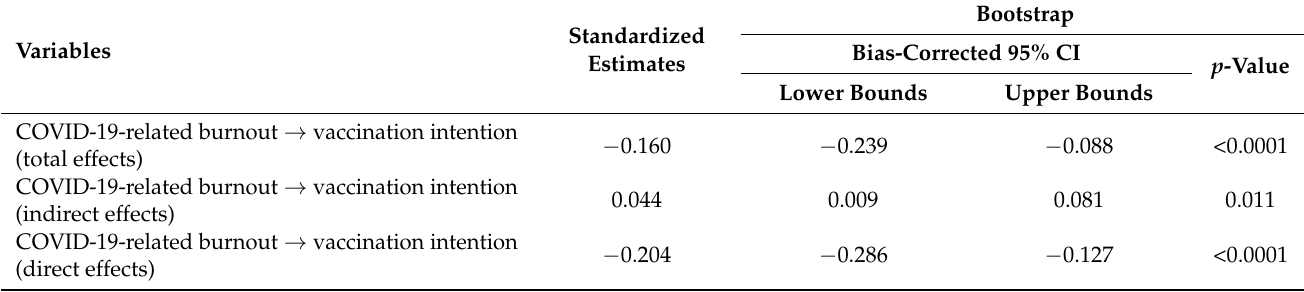
Figure 3. Standardized coefficients ( β ) from confirmatory factor analysis on the relationship between COVID-19-related burnout, vaccination intention, and resilience. * Statistically significant. Table 5. Standardized total, indirect, and direct effects from confirmatory factor analysis on the mediating role of resilience on the association between COVID-19-related burnout and vaccination